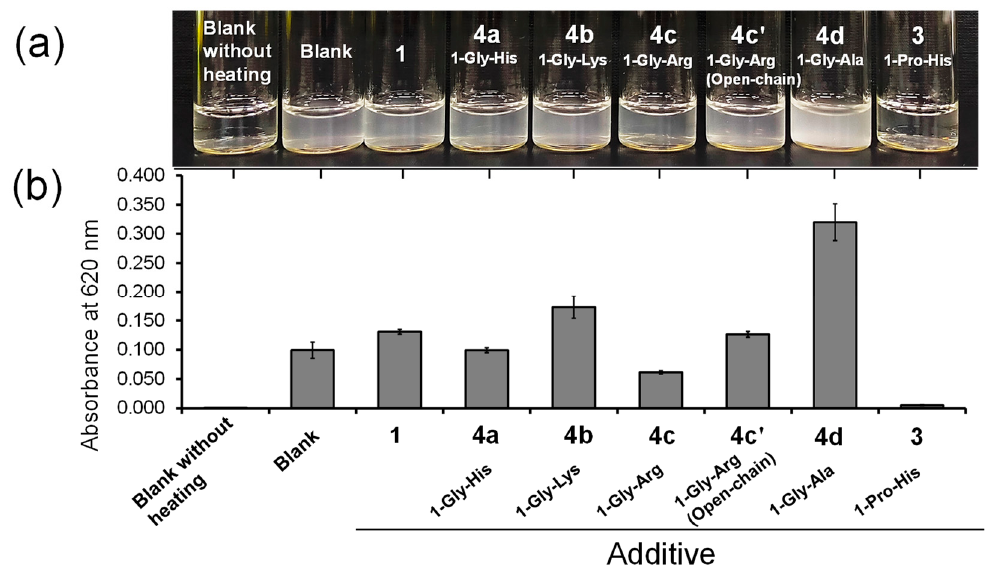
Figure 8. Thermal denaturation-induced aggregation of HEL. ( a ) Photograph of HEL (100 µ M) in a buffer solution containing no compound or 0.5 mM compound, 0.28 M NaCl, and 1 mM EDTA at pH 7.5 and 23 ◦ C obtained after heat-denaturation at 90 ◦ C for 10 min. ( b ) Light scattering at 620 nm due to generation of visible precipitation of HEL aggregates. Reaction conditions were the same as in ( a ).